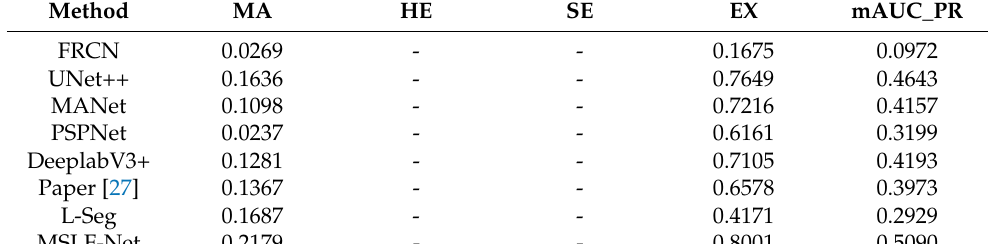
Table 3. Comparison experiments based on e_ophtha.